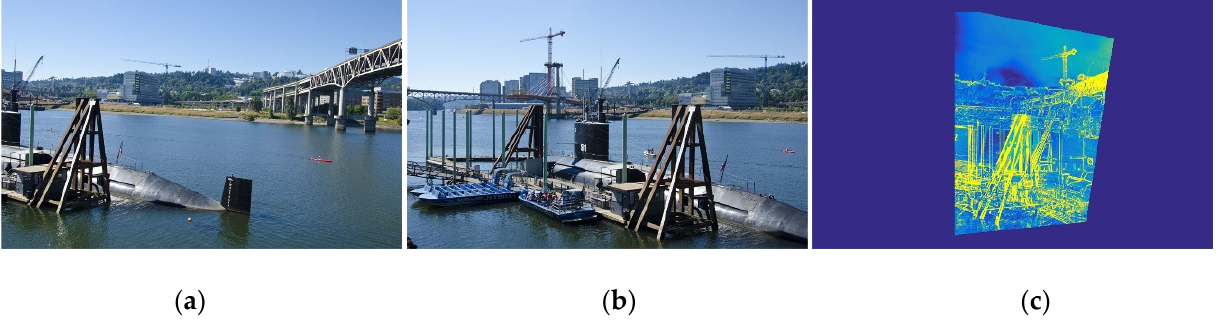
Figure 6. Input images and their difference cost map. ( a , b ) Two input images to be stitched. ( c ) Difference cost map of the overlapping region obtained with the proposed method, where the heat map is used for clear display.